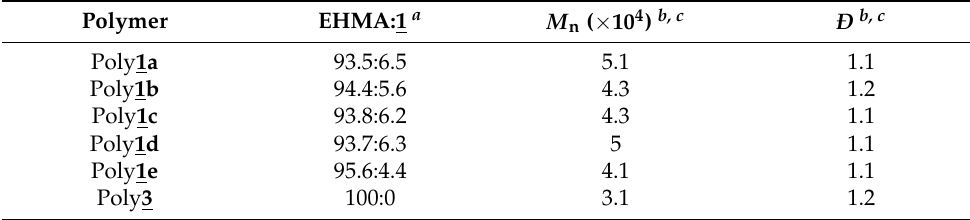
Table 1. Physical Properties of the Gallic-Acid-Bearing Polymers.